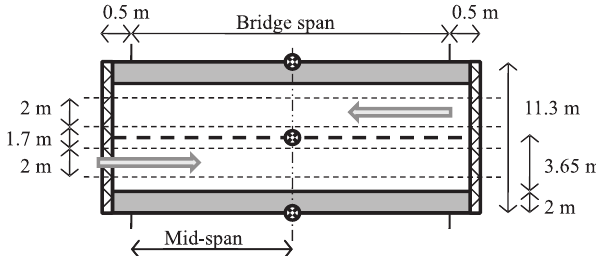
Fig. 4. Plan view of bridge showing wheel paths ( ), expan- sion joints ( ) and moment locations under study ( )